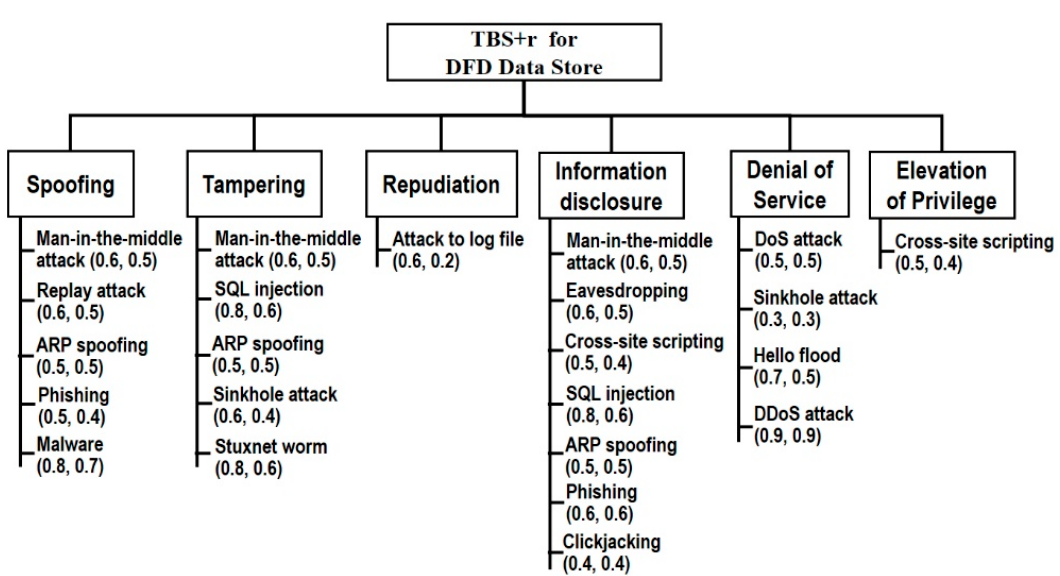
Figure 2. The TBS+r for DFD Process. Figure 2. The TBS + r for DFD Process.